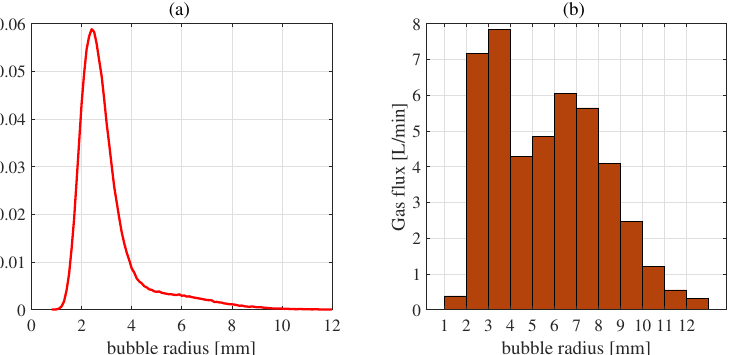
Figure 14. ( a ) Bubble radius distribution obtained by the volume-scattering strength optimization model. According to the estimation results, the bubble radius was in the range of 1–12 mm. ( b ) Gas leakage flux results for each bubble radius range. The highest gas leakage flux was contributed by bubbles with a radius from 3 mm to 4